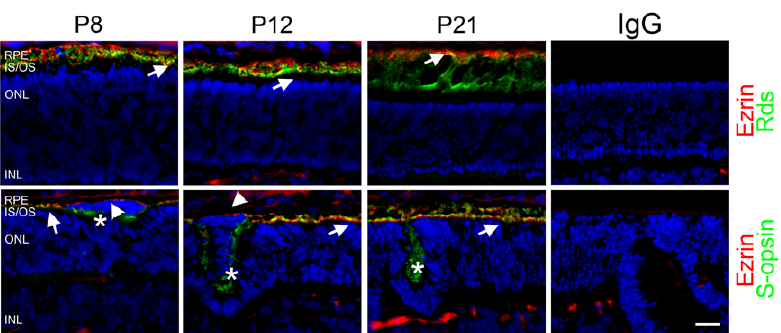
Figure 7. Associations between the RPE and photoreceptors are maintained in the Nrl 2 / 2 retina. RPE microvilli were labeled with ezrin antibody (red) and OSs were stained with Rds in WT or S-opsin antibody in Nrl 2 / 2 (green). Under normal conditions the RPE microvilli surround the apical portion of the photoreceptor OSs producing a yellow color (arrows). This association can be seen in both the WT and the Nrl 2 / 2 retinas. Ezrin staining does not extend into either the developing or the mature rosettes (asterisks). Directly between the aberrant photoreceptors and the RPE only ezrin labeling is observed (arrowheads). IS/OS: inner segments/outer segments, ONL: outer nuclear layer, INL: inner nuclear layer, RPE: retinal pigment epithelium. Scale bar, 20 m m.